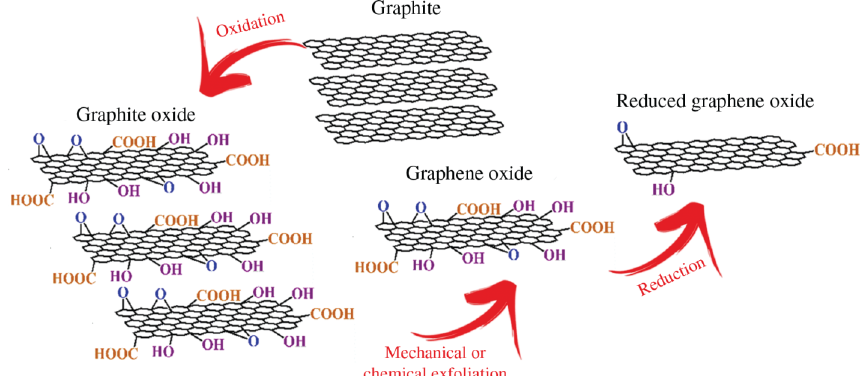
Figure 5: Schematic representation of the reduced graphene oxide production by the mechanical or chemical exfoliation